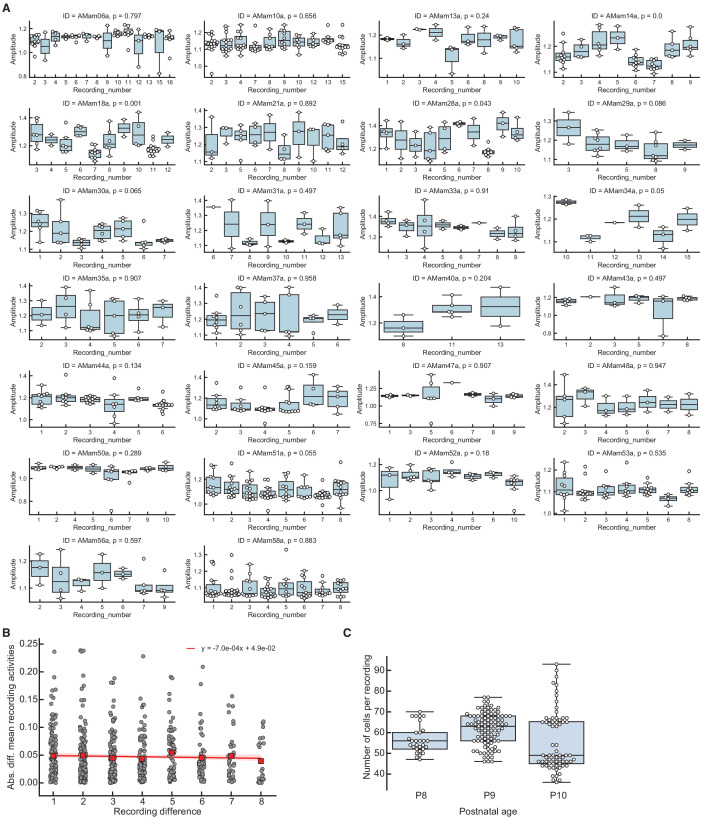
Fluctuations in cortical activity cannot generate correlations between event amplitude and average preceding activity. (A) Spontaneous events have similar mean amplitudes across consecutive recordings (each ∼5 min long) in the same animal (3–14 recordings in 26 animals separated by <5 min due to experimental constraints on data collection). Each plot corresponds to one animal, where each boxplot contains the event amplitudes (both L- and H-events) from each recording. Horizontal line indicates median, the box is drawn between the 25th and 75th percentile, whiskers extend above and below the box to the most extreme data points that are within a distance to the box equal to 1.5 times the interquartile range and points indicate all data points. p-Values of one-way ANOVA tests of the event amplitudes across recordings are shown for each animal. (B) Absolute difference in the mean event amplitude as a function of time between recordings. Mean values of each recording difference shown as red squares. The values follow the same distribution (Kruskal-Wallis test p=0.41). The slope of the linear regression fit (red) is very close to 0, confirming that no clear trend of increasing/decreasing activity exists across recordings. (C) Number of cells per recording, grouped by different postnatal ages. Horizontal line indicates median, the box is drawn between the 25th and 75th percentile, whiskers extend above and below the box to the most extreme data points that are within a distance to the box equal to 1.5 times the interquartile range and points indicate all data points.